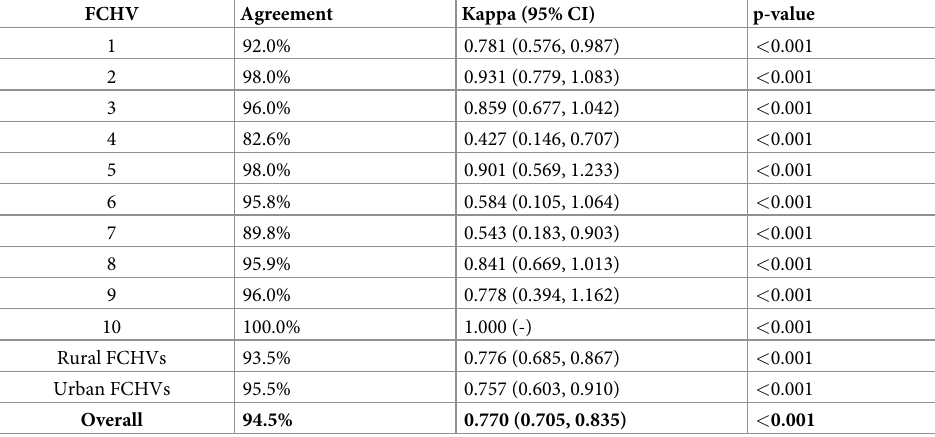
Table 1. Capacity assessment (Direct degree of agreement and kappa statistic) by comparing FCHVs’ and doctor’s screening results.